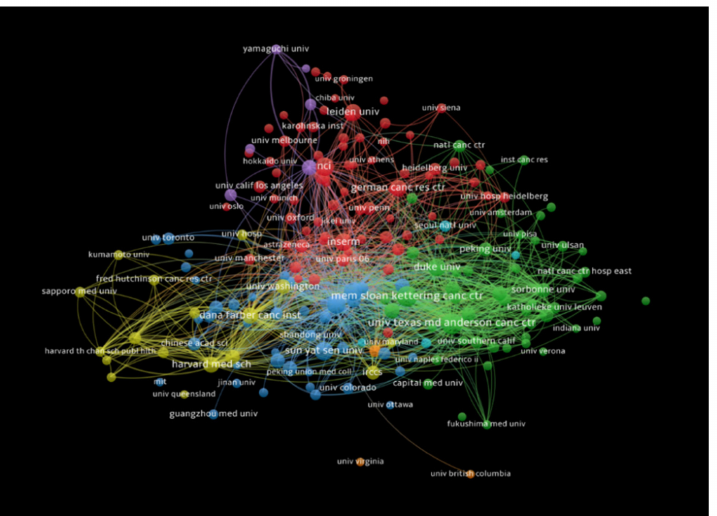
Figure 6. Bibliometric analysis of the institutions in the publications of immunotherapy in CRC showing institutions receiving top citations, where the size of nodes indicates the number of citations